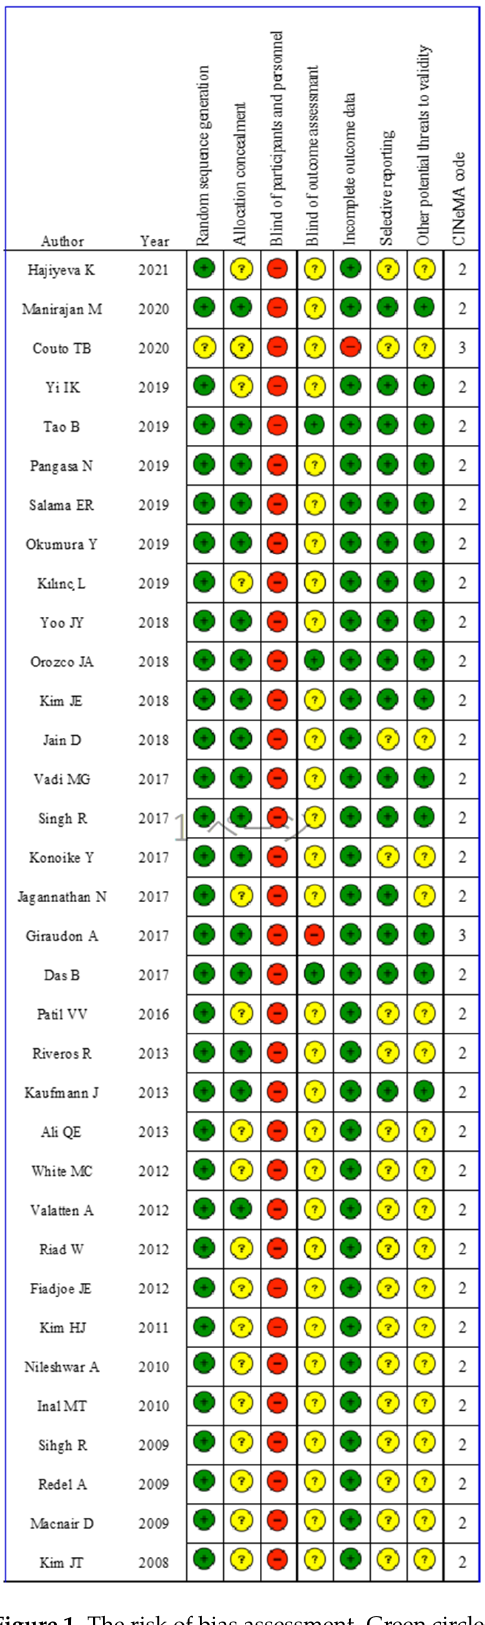
Figure 1. The risk of bias assessment. Green circles, red circles, and yellow circles indicate “low risk of bias”, “high risk of bias”, and “unclear risk of bias”, respectively.